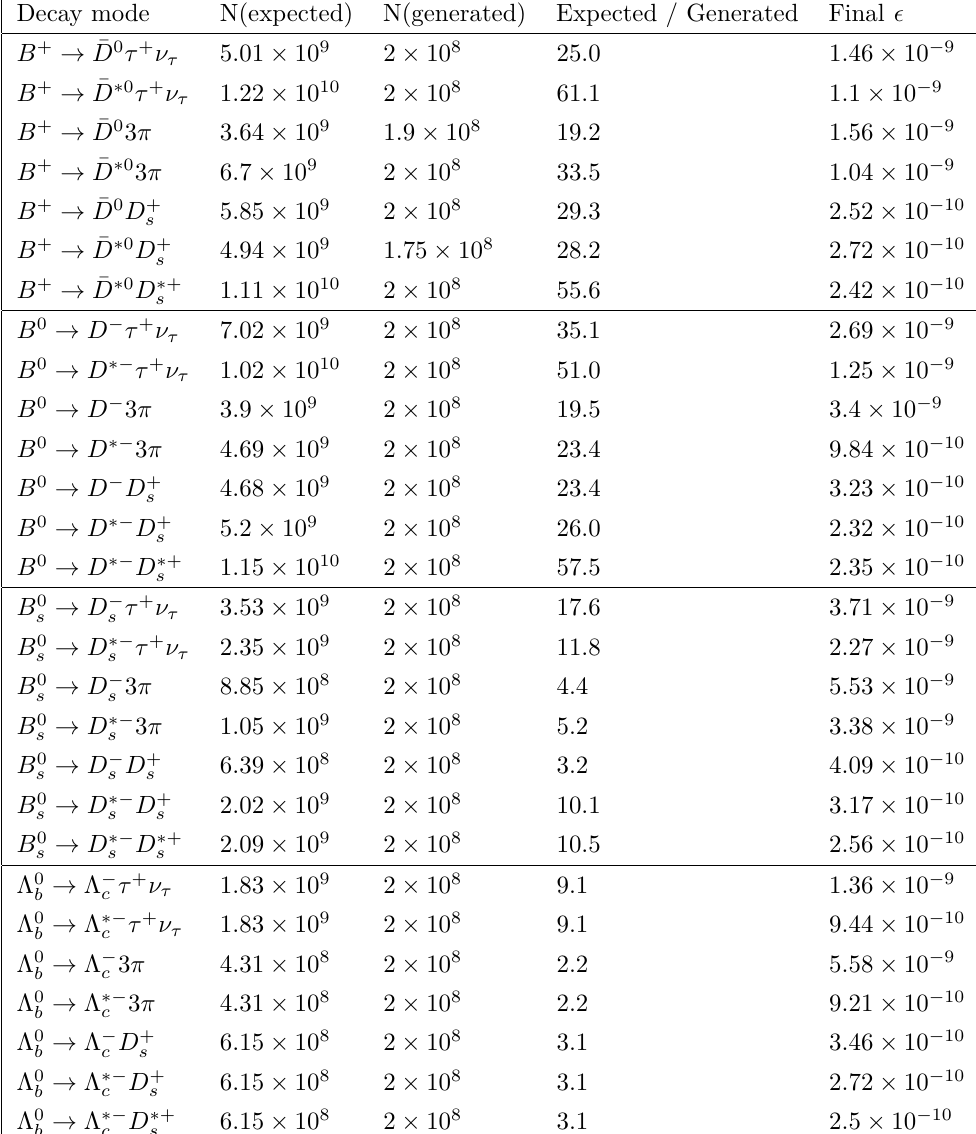
Table 2 . Summary of the exclusive B -hadron background samples used for determination of the optimal BDT cuts and to model background in the signal yield fit. The yields expected for each decay mode with N = 5 × 10 12 are shown in the second column, and the generated sample Z statistics are shown in the third column. The large ratio between expected and generated statistics (fourth column) illustrates why cut-and-count efficiencies cannot be used to determine the expected background rejection achieved by the double-BDT selection; for many background modes, none of the generated events survive the optimal BDT cuts applied. The efficiency values determined using the spline parameterisation approach are given in the final column. Using splines derived from the total exclusive sample enables efficiencies down to the 10 − 10 level to be